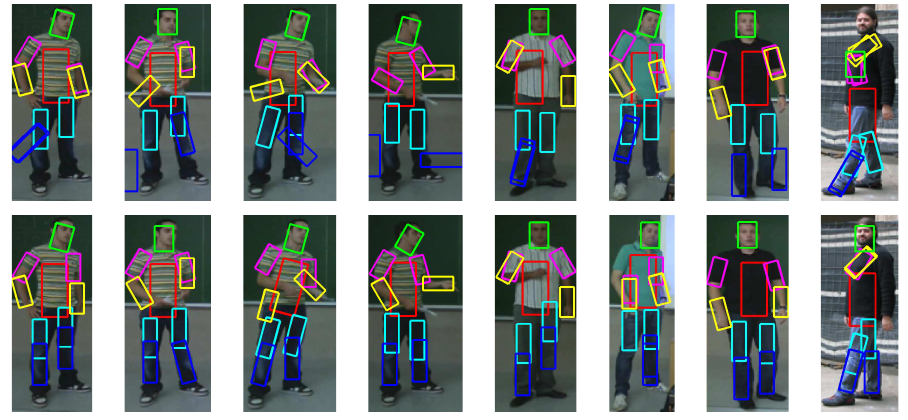
Figure 10. Human Limb dataset results. Up row: limb recovery without ST-GrabCut segmentation. Down row: limb recovery with ST-GrabCut